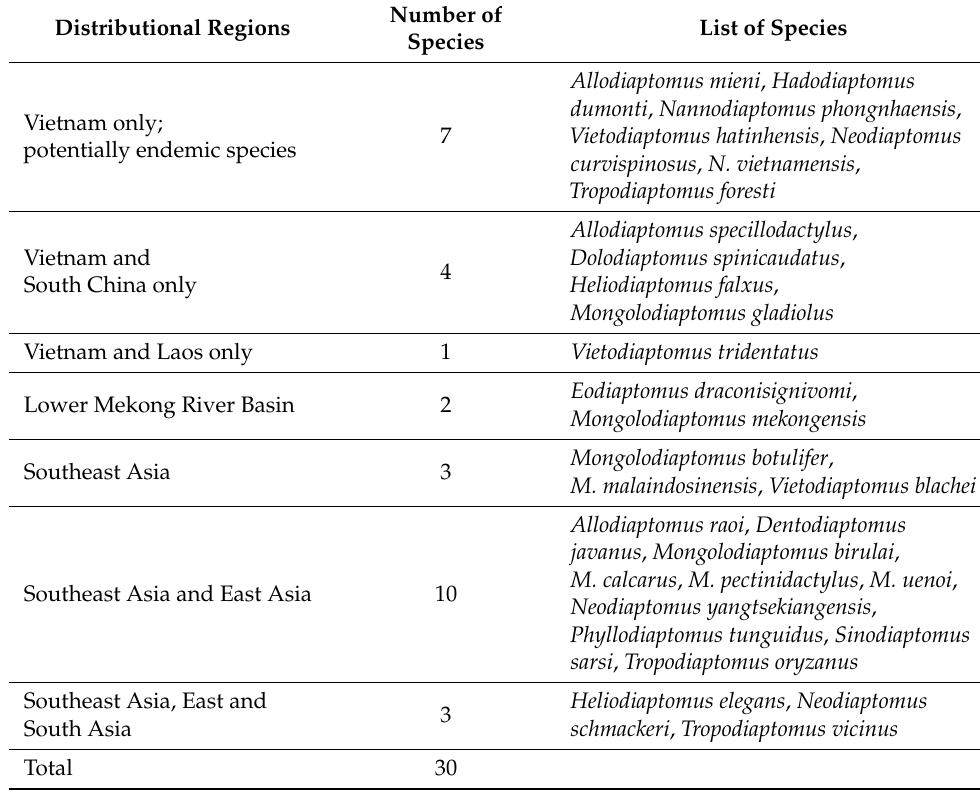
Table 7. Diaptomid copepods from Vietnam are classified according to their geographic distribution. The Lower Mekong River Basin region consists of Thailand, Myanmar, Laos, Cambodia, and Vietnam. The Southeast Asian region consists of Thailand, Myanmar, Laos, Cambodia, Vietnam,